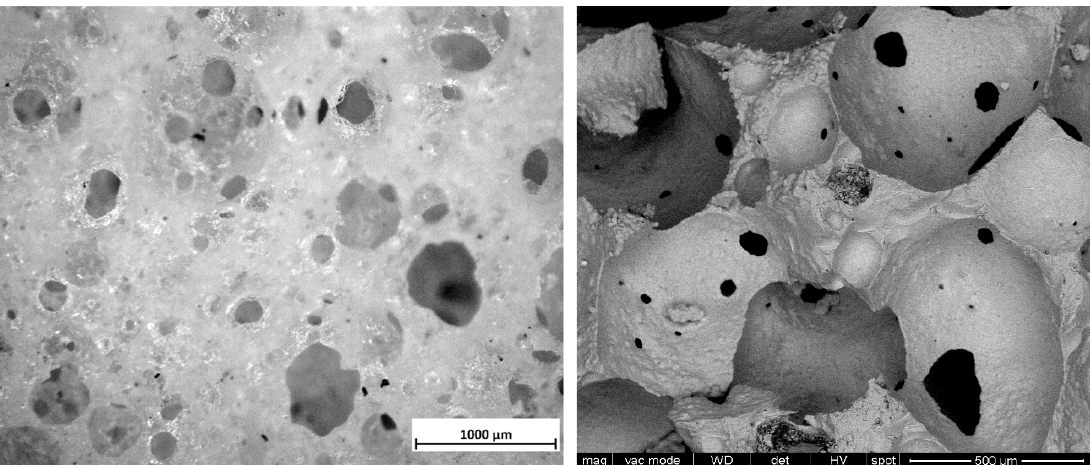
Figure 8. Fired foam: cellular structure (left, optical stereomicroscopy image); high magnification detail (right, SEM image).